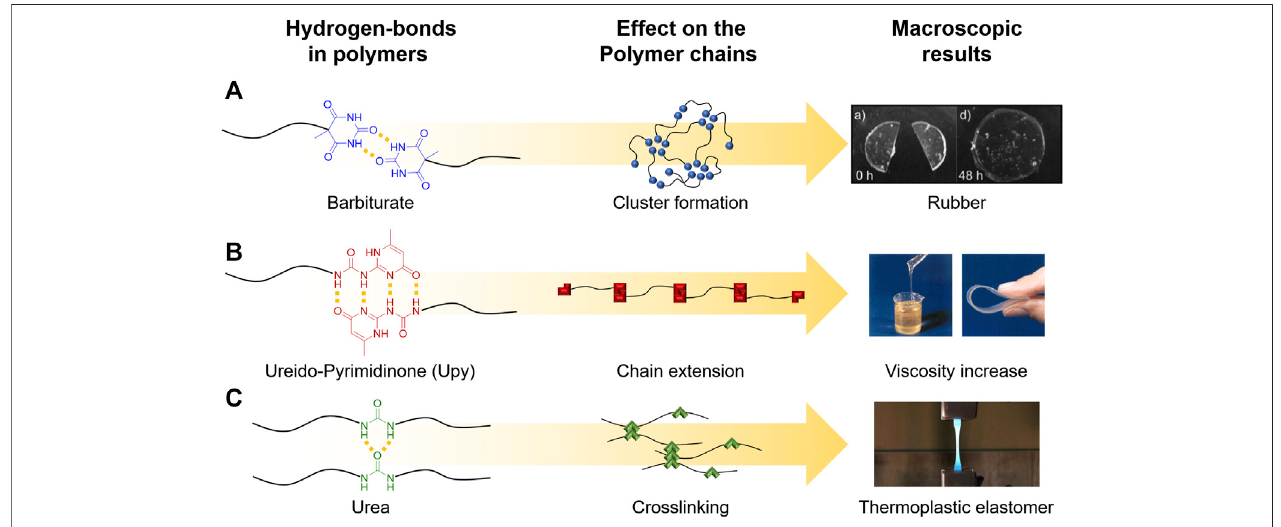
FIGURE3| Clusterformationofthebarbiturateaggregatesinbivalenttelechelicpoly-isobutylene(PIB) – barbiturateformingadynamicnetwork (A) .Chainextension in telechelic ureidopyrimidinone (UPy)-modi fi ed polymers and their effect on viscosity (B) . Hydrogen bonds inside the polymer chain lead to non-covalent crosslinking to obtain thermoplastic elastomers (C) . Adapted with permission (Folmer et al., 2000; Herbst et al., 2012; Reppel et al., 2013). Copyright 2012, The Royal Society of Chemistry. Copyright 2000, John Wiley and Sons. Copyright 2013, Technische Mechanik.